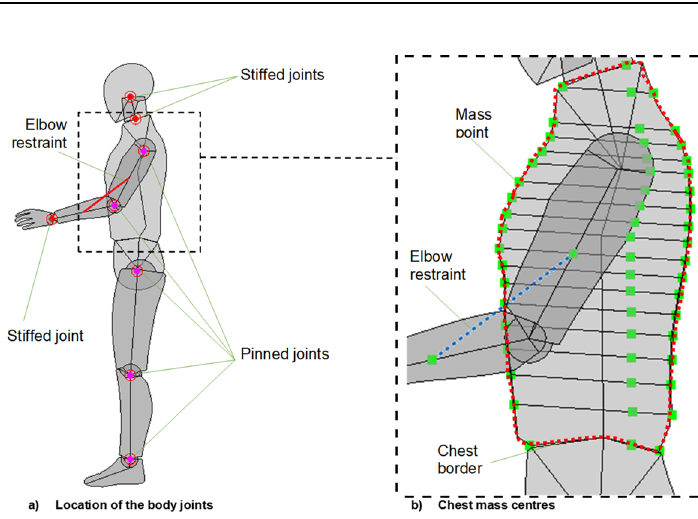
Figure 6. Modelled human body joints.